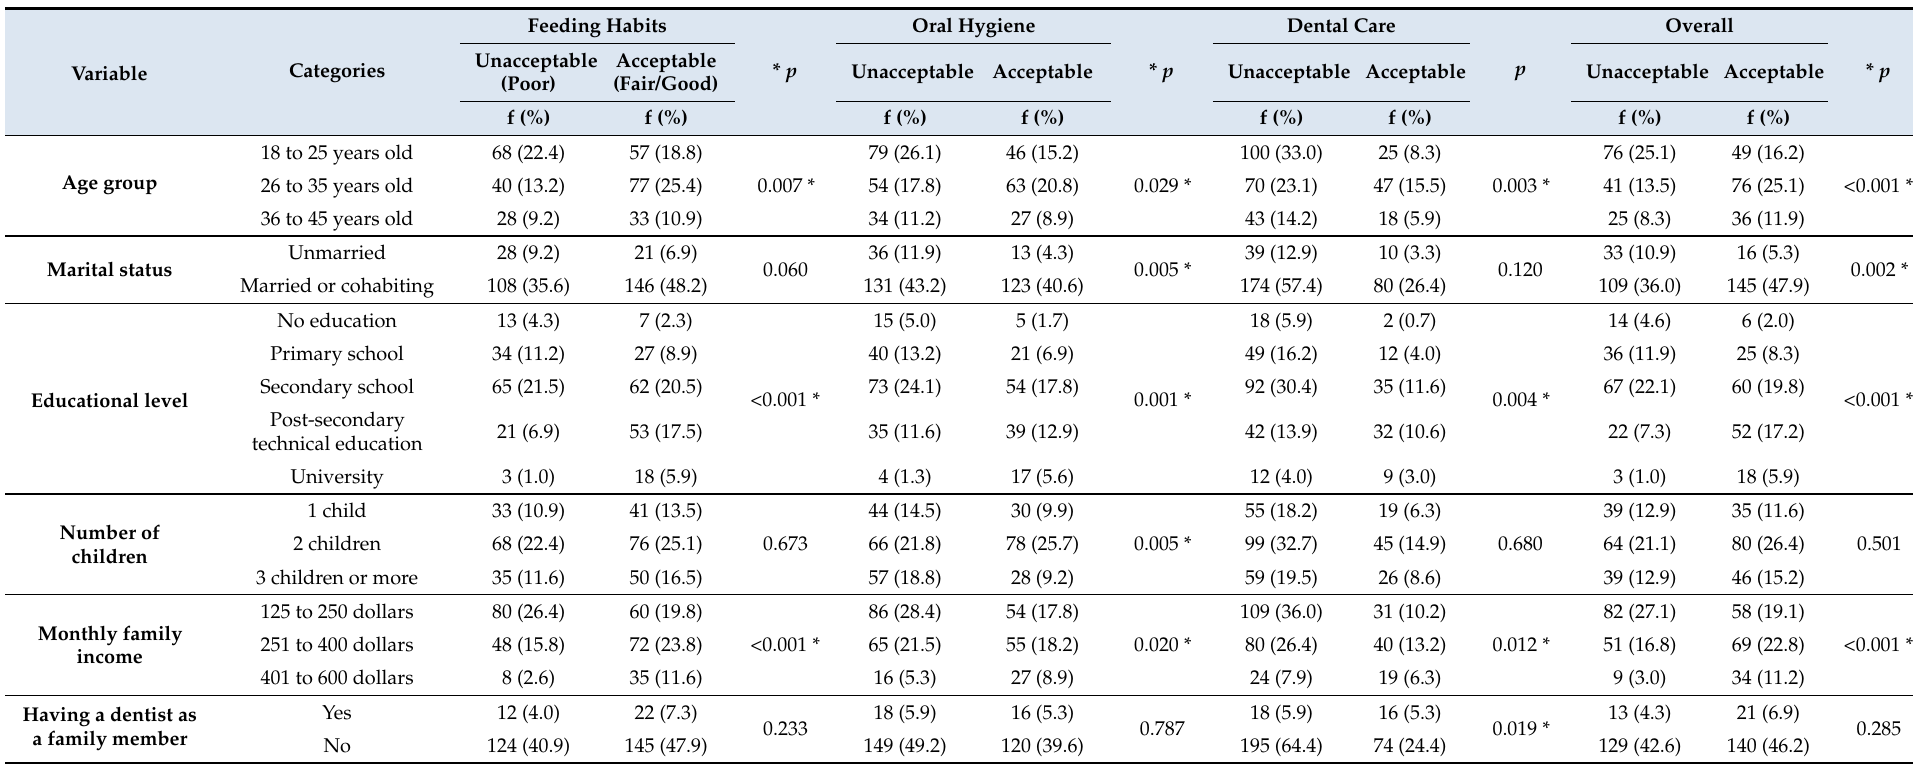
Table 5. Association of sociodemographic factors of early postpartum women with knowledge about oral health prevention in infants aged 0 to 2 years old. Feeding